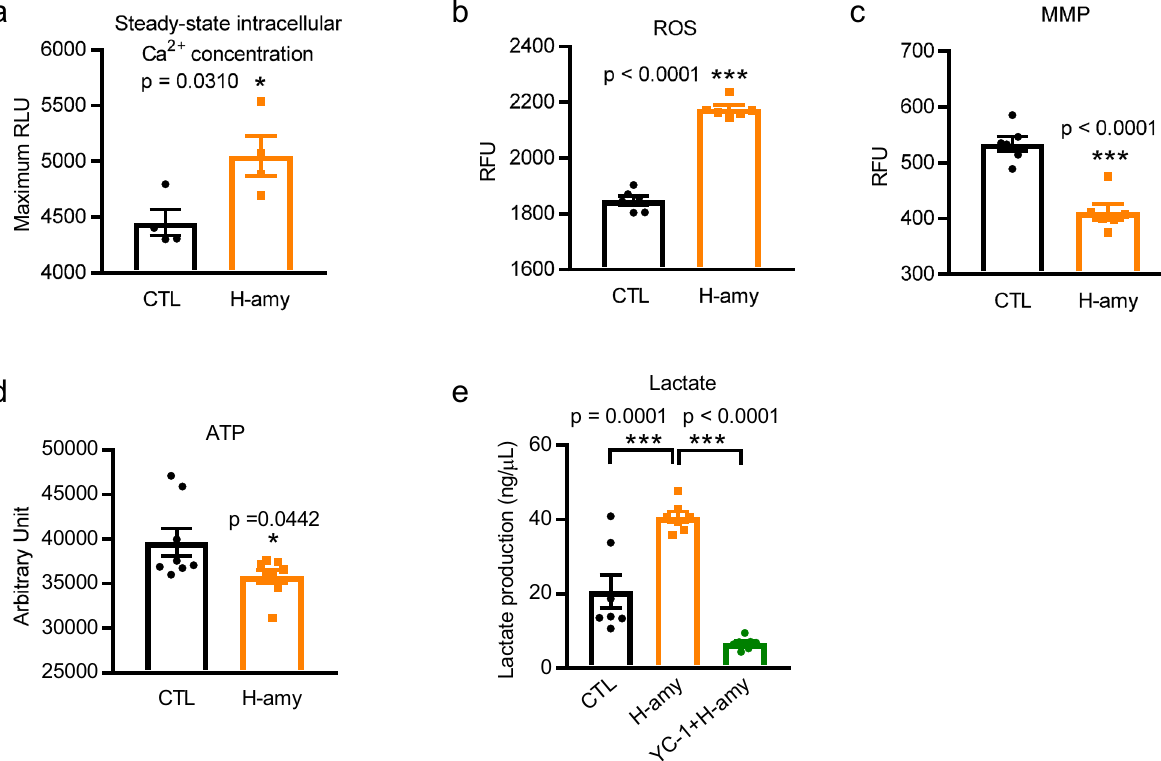
Fig. 8 Cardiac amylin accumulation induced changes in Ca 2 + level, oxidative stress, mitochondrial function and lactate production in hiPSC-CMs. a Steady-state intracellular Ca 2 + concentration was measured in hiPSC-CMs incubated with or without amylin for 2 h ( n = 4/group). b ROS production was compared in hiPSC-CMs treated as in panel ( a ) ( n = 6/group). c Mitochondrial membrane potential (MMP) ( n = 6/group) and d ATP level ( n = 8/group) were measured in hiPSC-CMs treated with amylin for 2 h. e Effect of pre-treatment with HIF1 α inhibitor YC-1 on lactate production induced by amylin ( n = 7/group). Data represent mean ± SEM. * P < 0.05; *** P < 0.001 by Student ’ s t test ( a – d ) and One-way ANOVA with Tukey ’ s post-test ( e